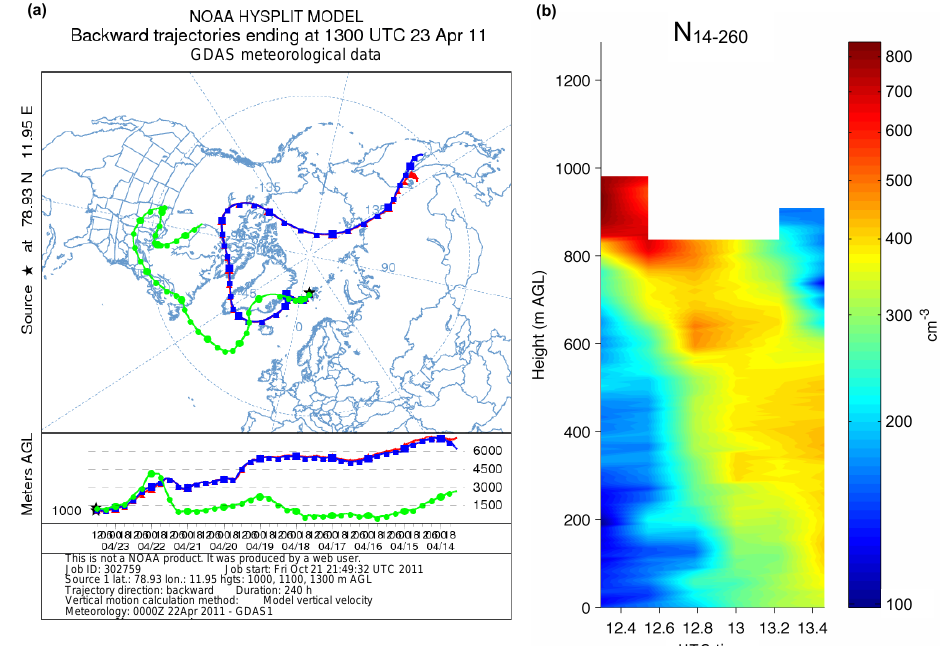
Figure 7. Case study of 23 April 2011 (12:00–13:30UTC): (a) air mass back-trajectories; (b) time evolution of N 14 − 260 obtained through the interpolation of six vertical profiles, each of which lasted ∼ 15min and was distanced ∼ 1min from the following profile.